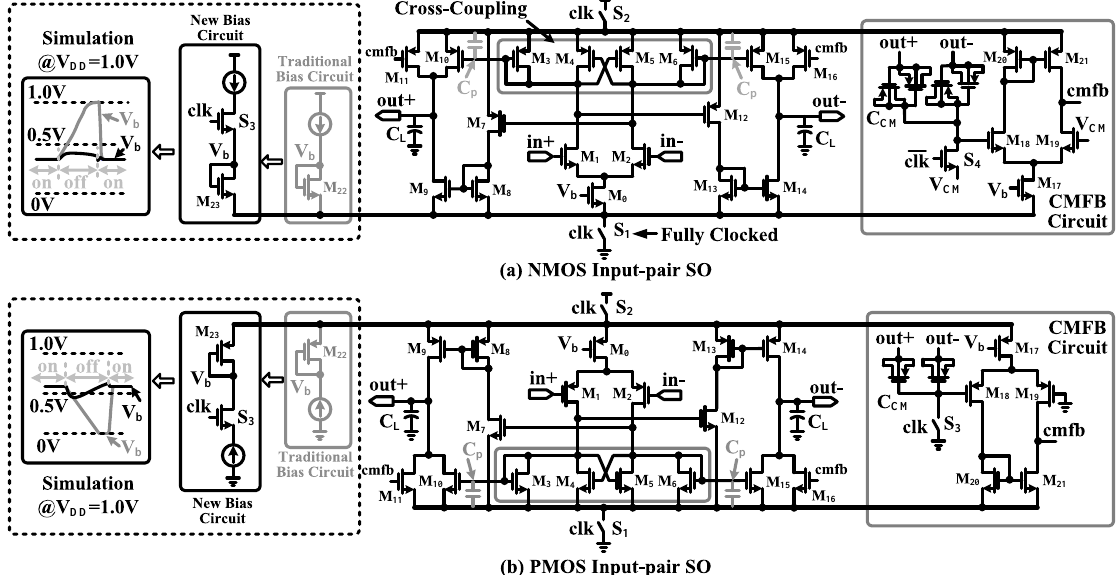
Figure 10. Fully-clocked power-efficient switched op-amps with the corresponding common